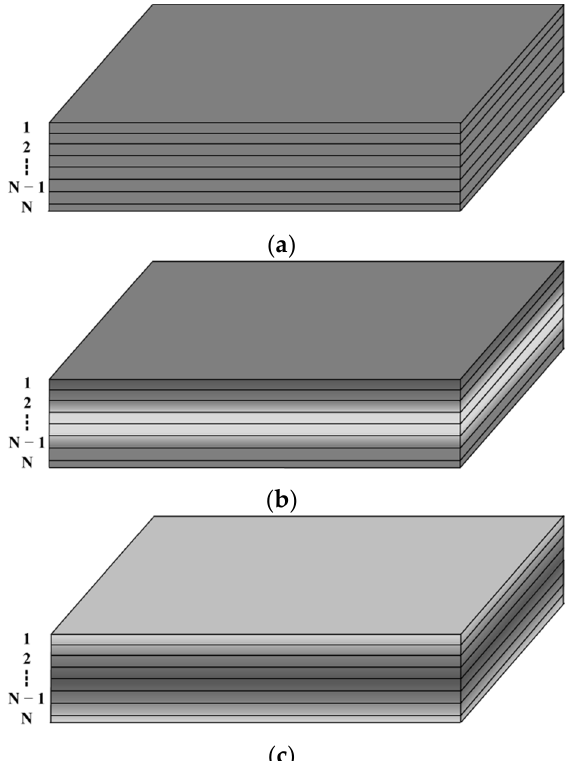
Figure 2. Distribution patterns along the thickness direction of GPLs: ( a ) U type, ( b ) X type, ( c ) O